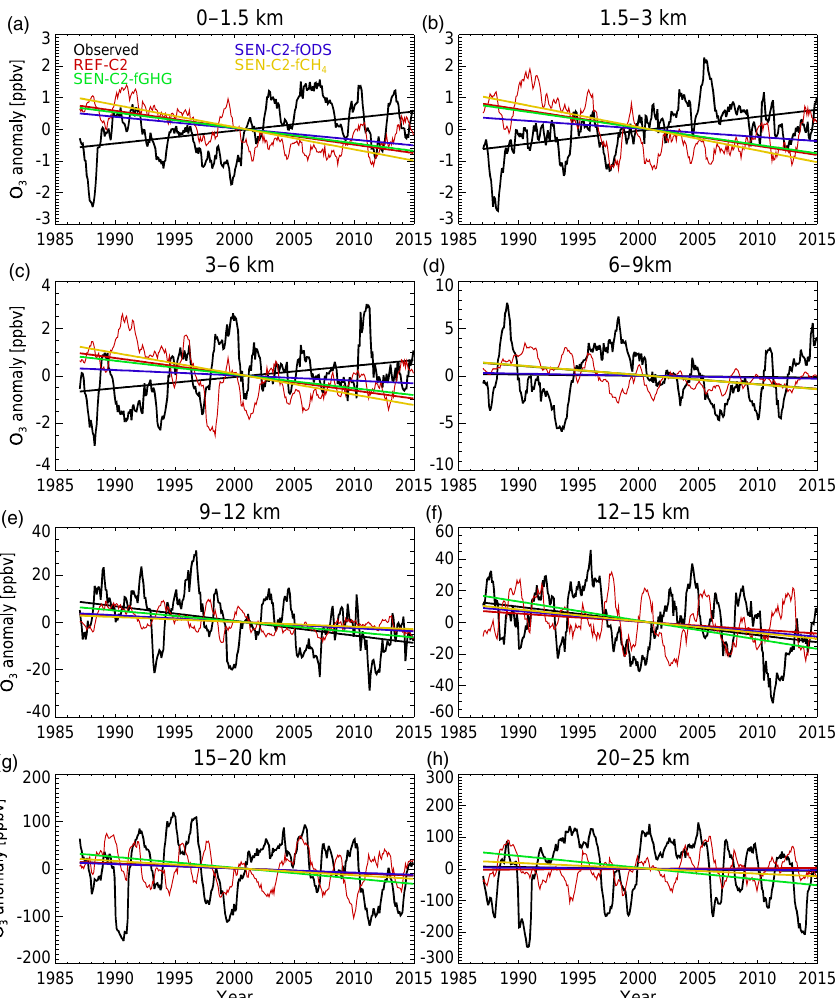
Figure 8. Observed (black) and modelled (REF-C2; red) O 3 anomalies and linear trends at Lauder over 1987–2014. Modelled linear trends from SEN-C2-fGHG (green line), SEN-C2-fCH 4 (gold line), and SEN-C2-fODS (blue line) are also depicted. Anomalies shown are smoothed with a 13-monthly filter for the purpose of